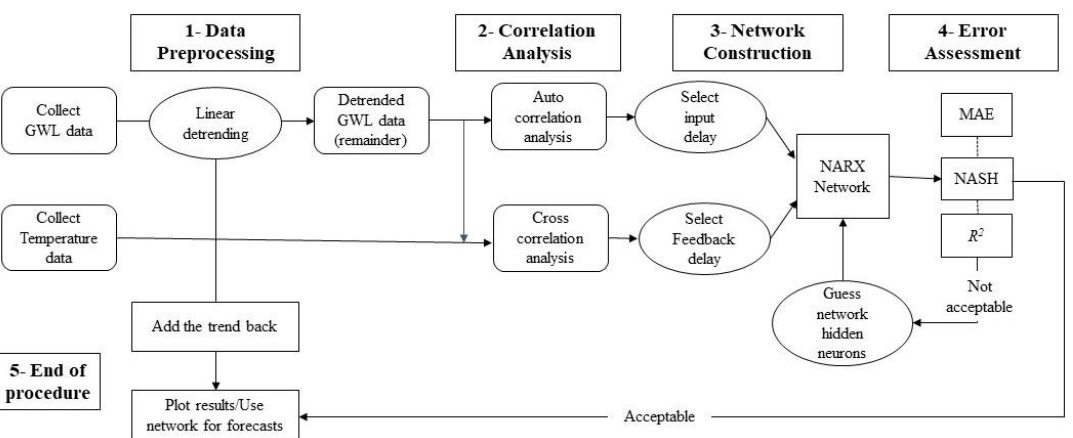
Figure 4. The sequential procedure for the nonlinear autoregressive modeling approach with exogenous input, (NARX)-based approach, for modeling groundwater level fluctuation in urban aquifers.